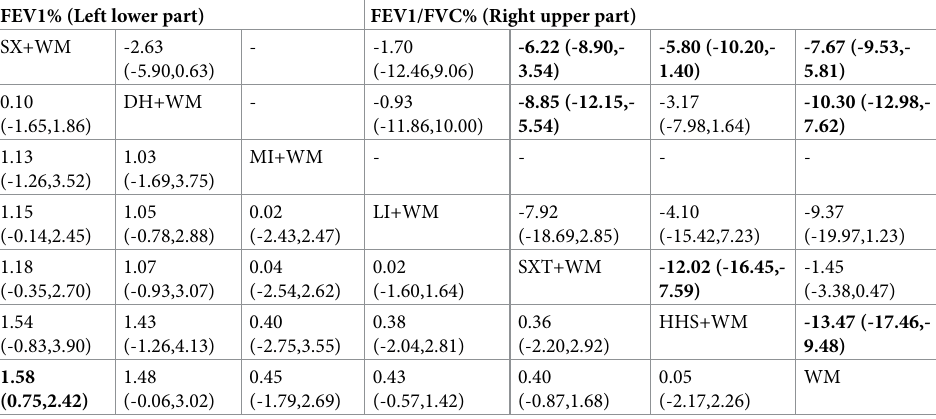
Table 6. Risk ratio/mean difference (95% CI) of the FEV1% and